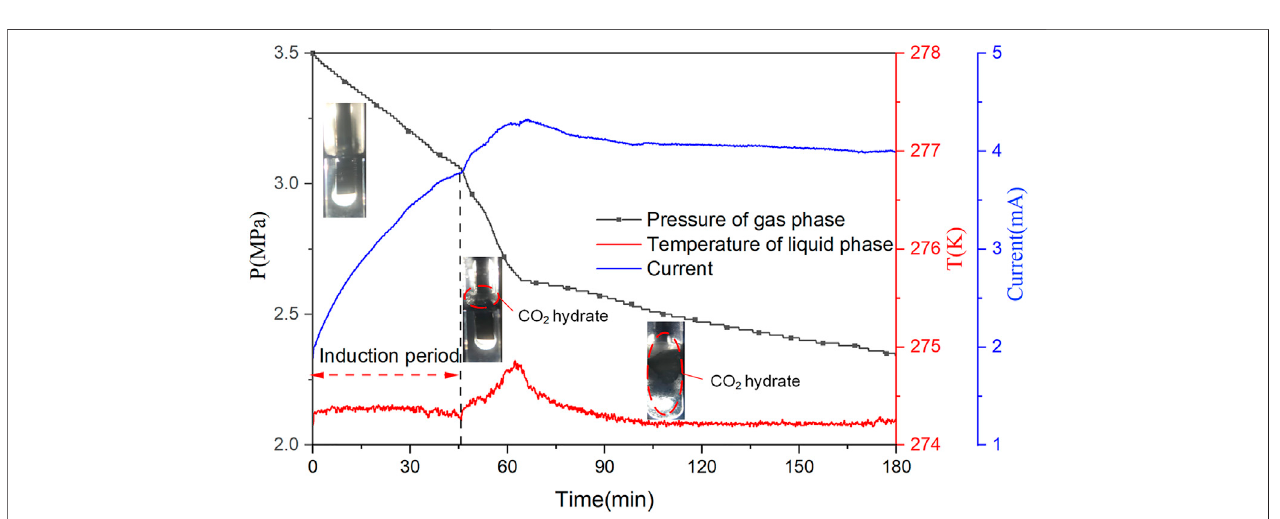
FIGURE 5| The pressure ofgas phase and temperature of liquid phase and current curves during the CO 2 hydrate formation process at 3.5 MPa and 274.15 K in the application of a voltage of 15 V.